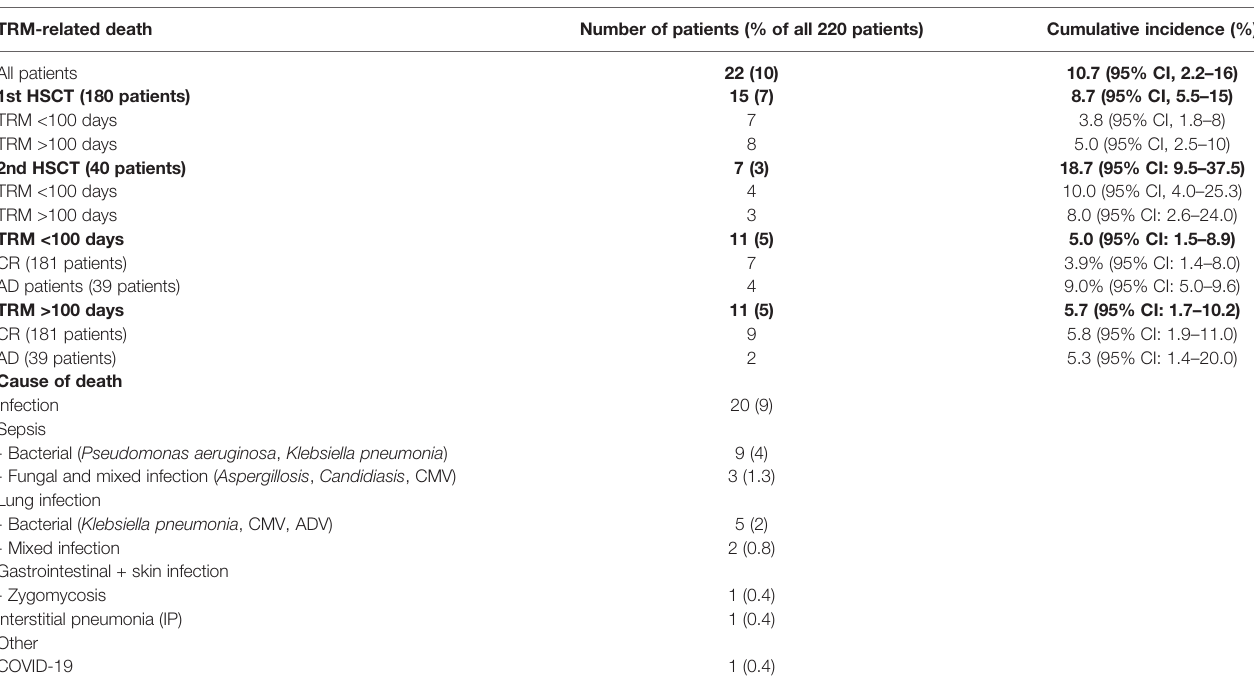
TABLE 6 | TRM-related death characteristic ( n = 22).